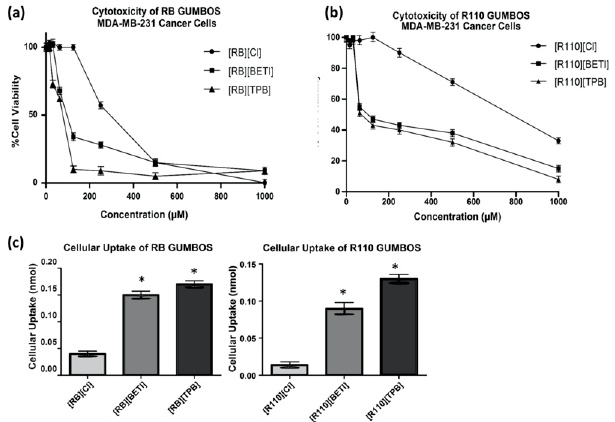
Figure 5 . ( a ) Toxicity of RB GUMBOS towards MDA-MB-231 cancer cells; ( b ) Toxicity of R110 GUMBOS towards MDA-MB-231 cancer cells; ( c ) Cellular Uptake of R123 nanoGUMBOS. (*) indicates significant difference in cellular uptake as compared to parent dye [RB][Cl] or [R110][Cl] for respective nanoGUMBOS with p = 0.05.